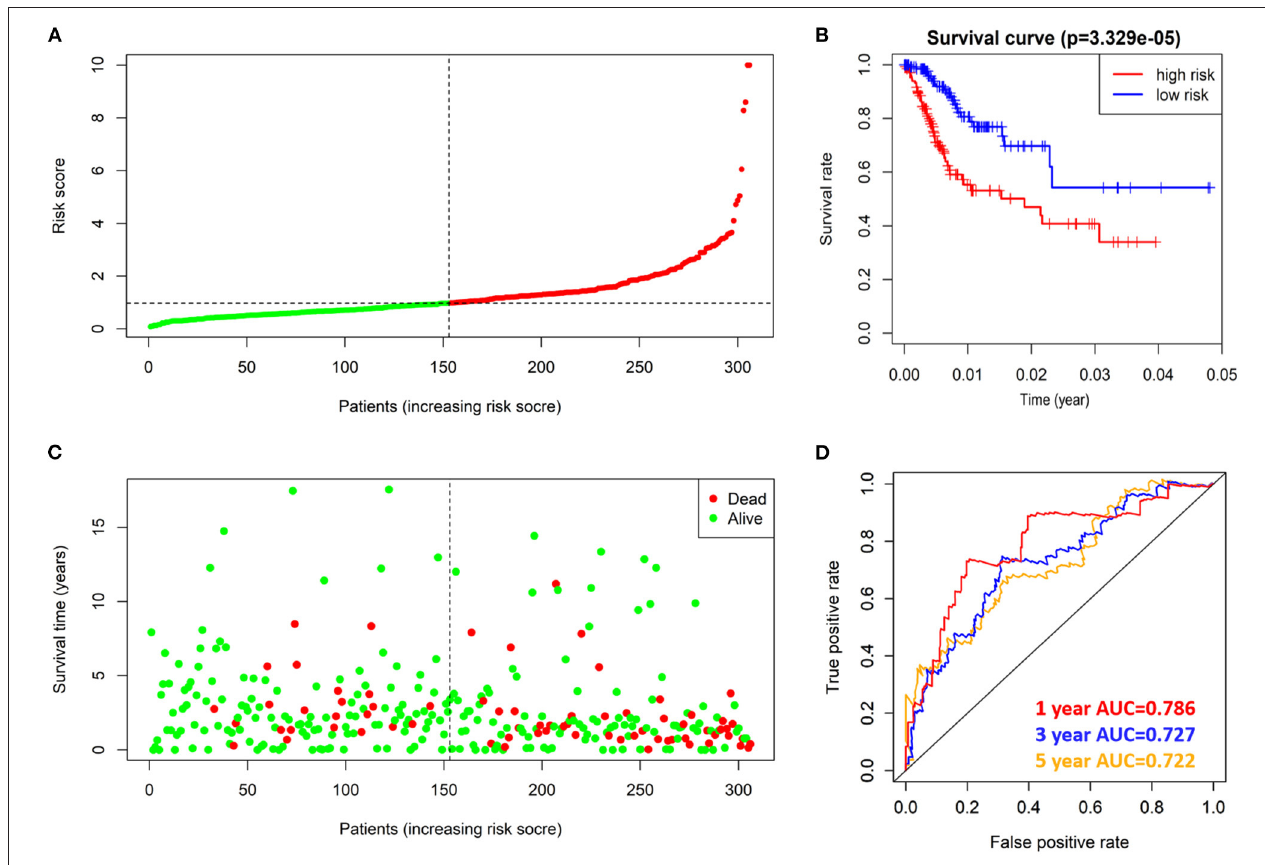
FIGURE 6 | prognostic value of 4 prognostic related RBPs risk models in TCGA dataset. (A) Distribution of risk scores in prognosis related RBPs models. (B) Kaplan-Meier survival curve of OS in high-risk group and low-risk group. (C) Different patterns of survival status and survival time between high-risk group and low-risk group. (D) ROC to evaluate the prognostic efficacy of risk score in predicting patients at 1, 3 and 5 years.